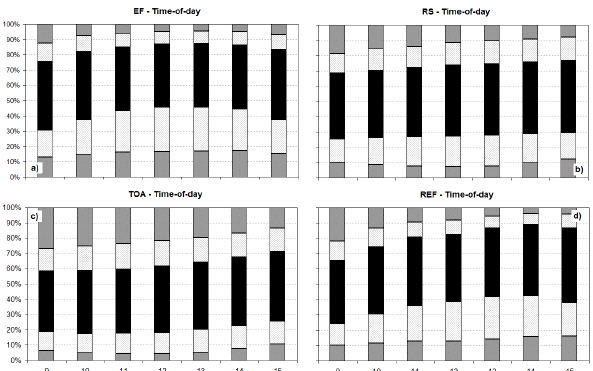
Figure 4. Monthly variability of the accuracy of upscaling meth- ods. The black central bar represents the frequency of data between ET max and ET min , the light-gray bars represent the “moderate” er- rors, while dark gray bars represent “major” errors. Frequencies of underestimation ( < ET min ) and overestimation ( > ET max ) are indi- cated by bars below and above the black bar, respectively. See the text for the definition of “moderate” and “major”